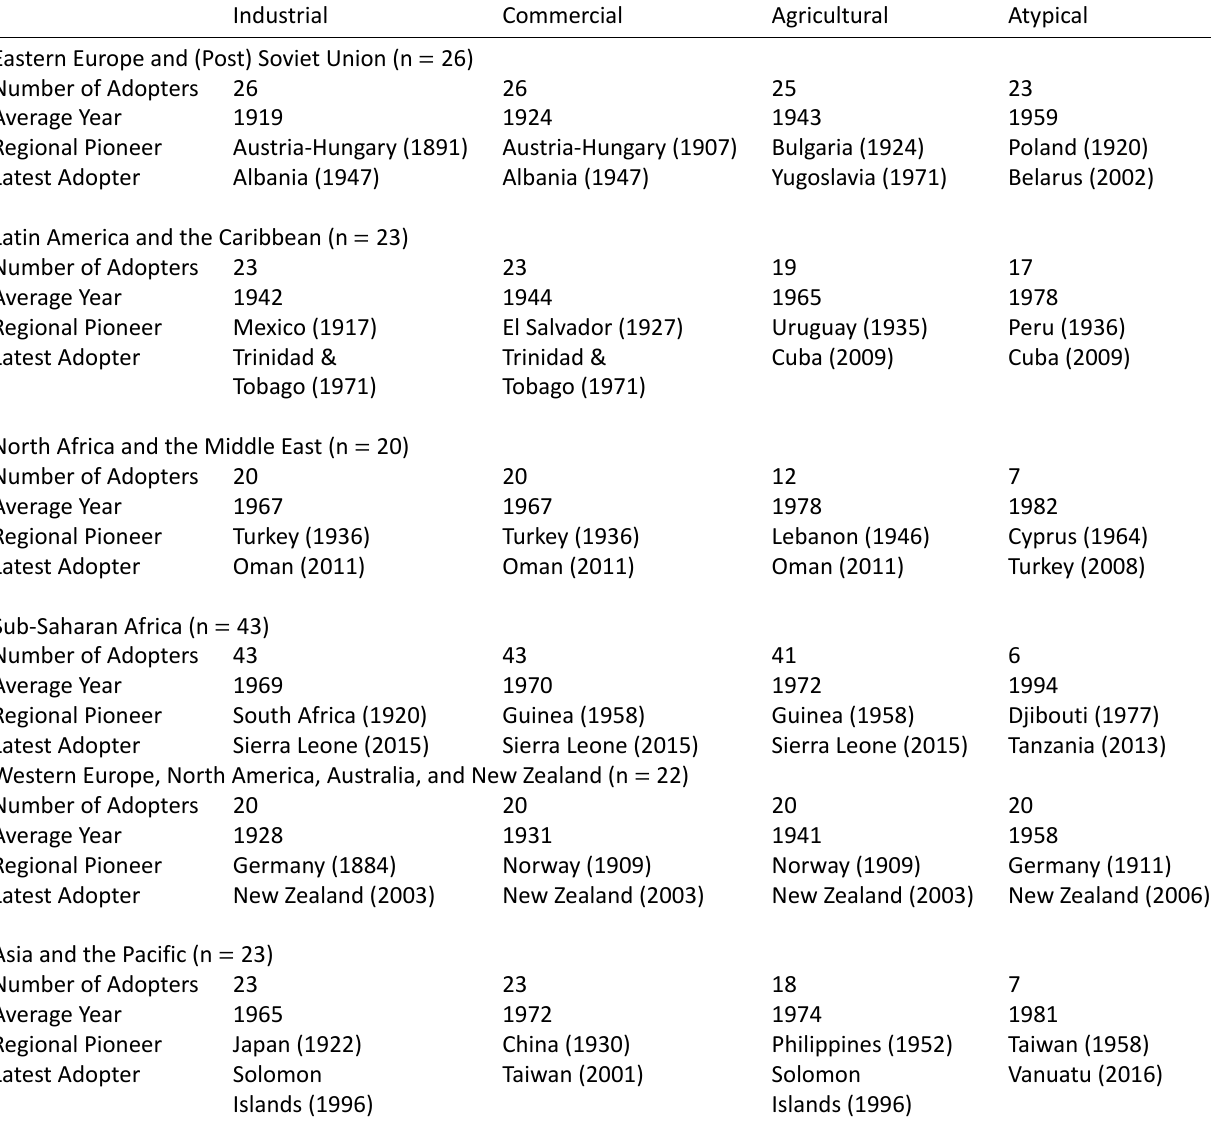
Table 2. The sequence of coverage expansion of paid maternity